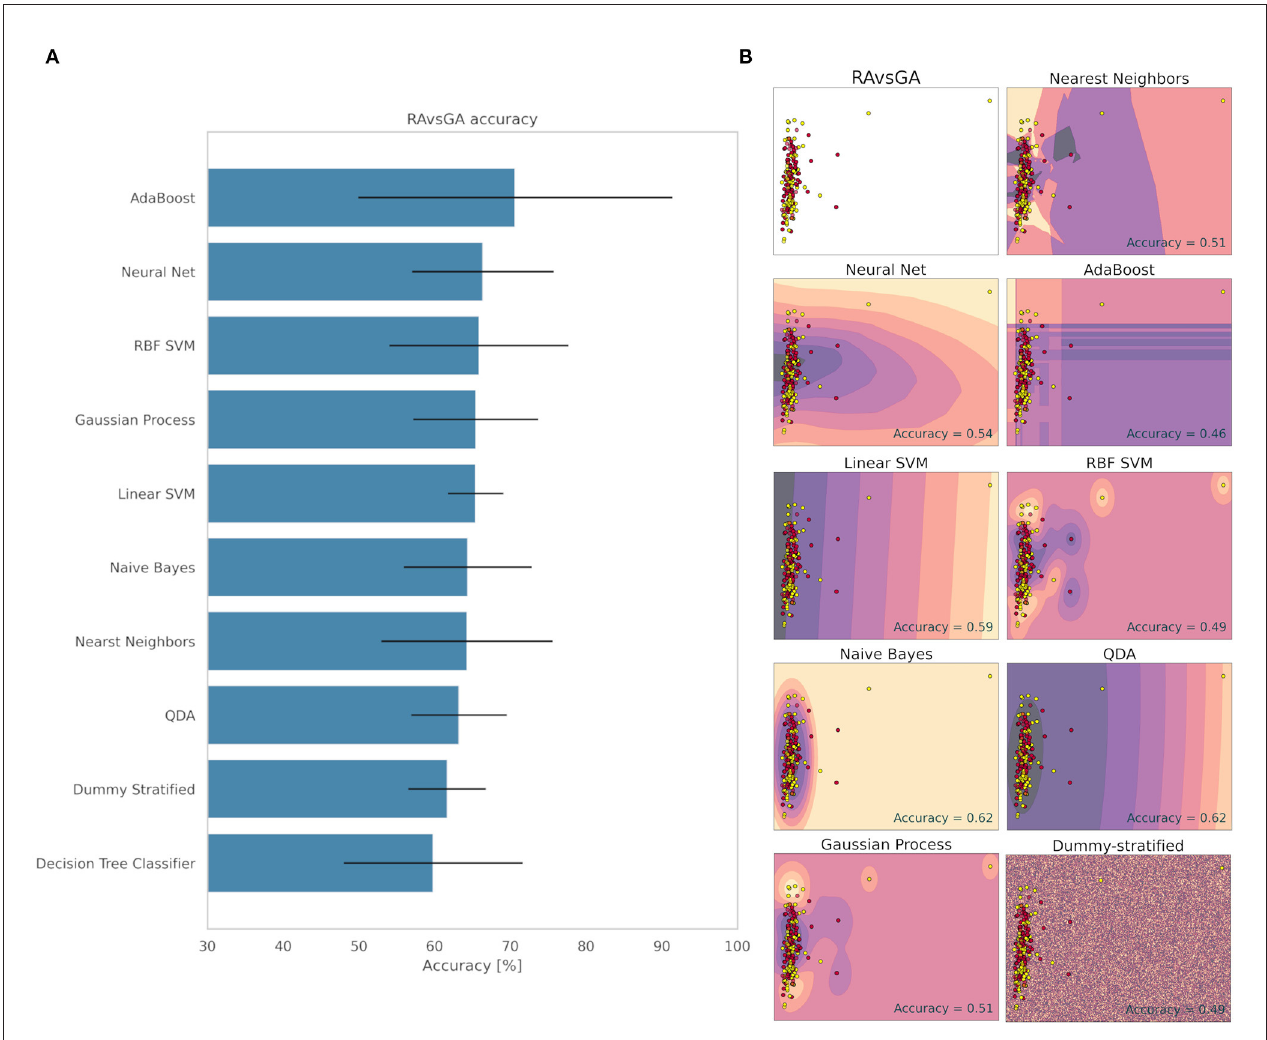
FIGURE 6 | Accuracy (%) and standard deviation (A) of the Machine Learning models used to classify RA and GA groups. Scatter plots (B) showing a sample space plan used in ML training for the RA × GA distribution. Red dots: RA; Light yellow spots: GA. The regions are the demarcations made by ML to indicate levels of certainty of classification. The darker it is, the more certain it belongs to the RA group. The clearer the more certainty of belonging to the GA group. The subtitle of each graph indicates the method used and in the lower right quadrant is the accuracy